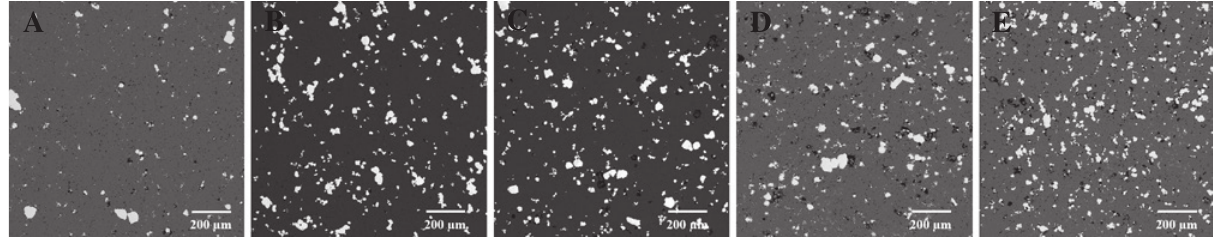
Figure 7: SEM micrographs of the internal microstructure of the composite Cu-W with different volume fractions of reinforcing particles: (A) 5%, (B) 10%, (C) 15%, (D) 20%, and (E) 30%.